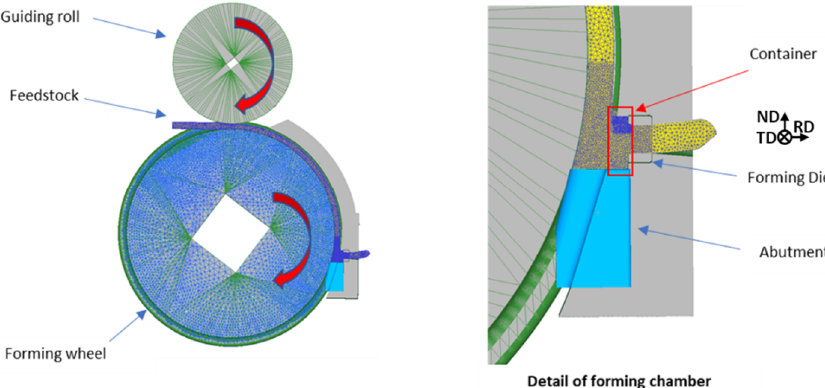
Figure 1. Schematic illustration of Conform severe plastic deformation (SPD) technique (coordinate system: ND-normal direction, RD-rolling direction, TD-transverse direction).